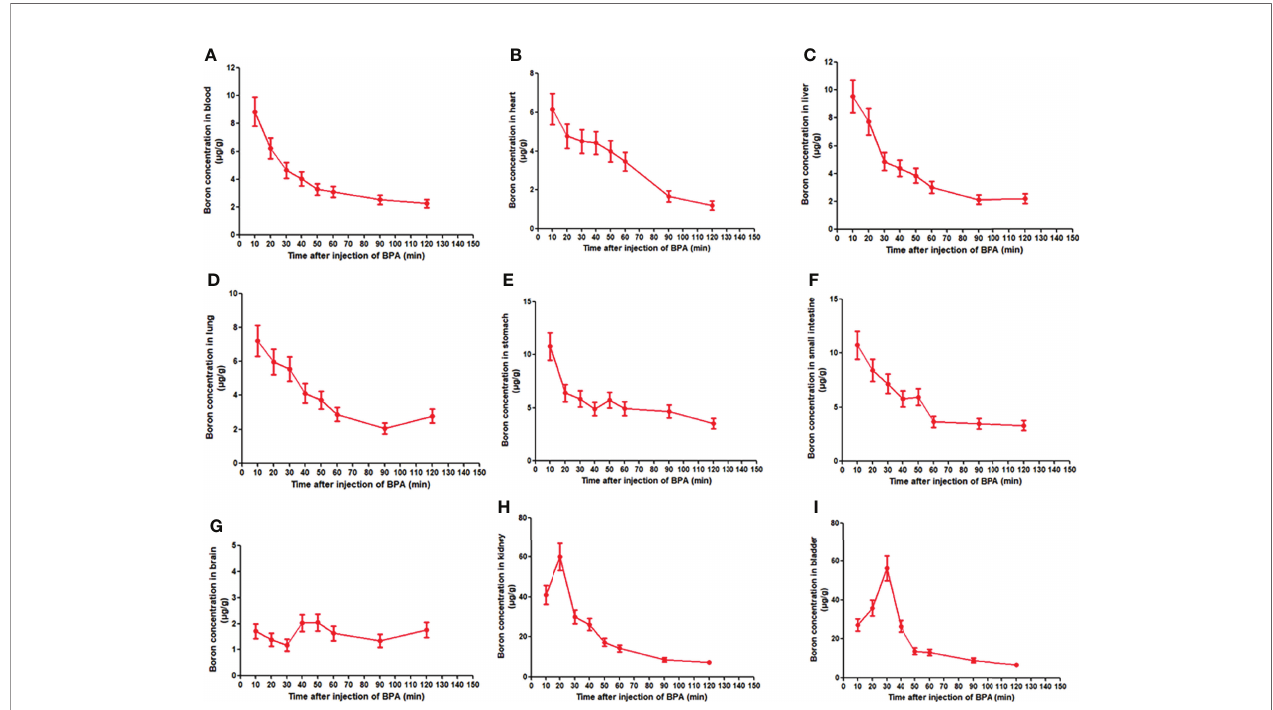
FIGURE 4 | Boron concentration – time curve of BPA in blood (A) and heart (B) , liver (C) , lung (D) , stomach (E) , small intestine (F) , brain (G) , kidney (H) , and bladder (I) of rats. Data were expressed as the means ± SD. N = 6. The dose of BPA was 125 mg/kg body weight. The age of male rats was 8 weeks. Blood and tissues were collected at 10, 20, 30, 40, 50, 60, 90, and 120 min after BPA injection for boron